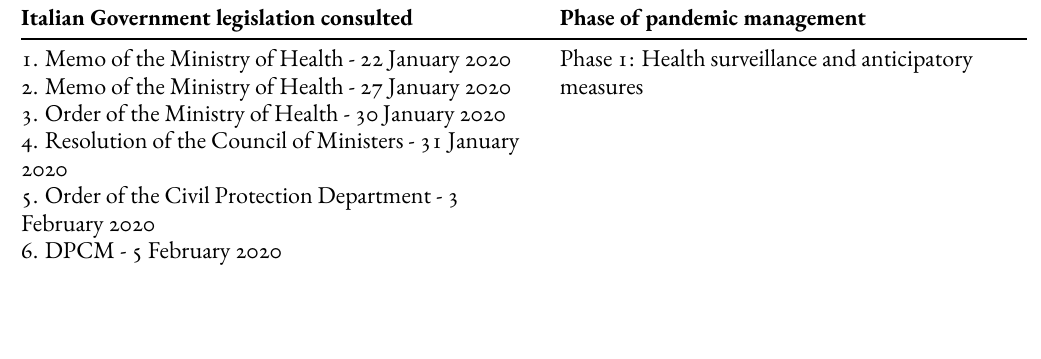
Table 1 – List in chronological order of the regulatory documents of the Italian Government